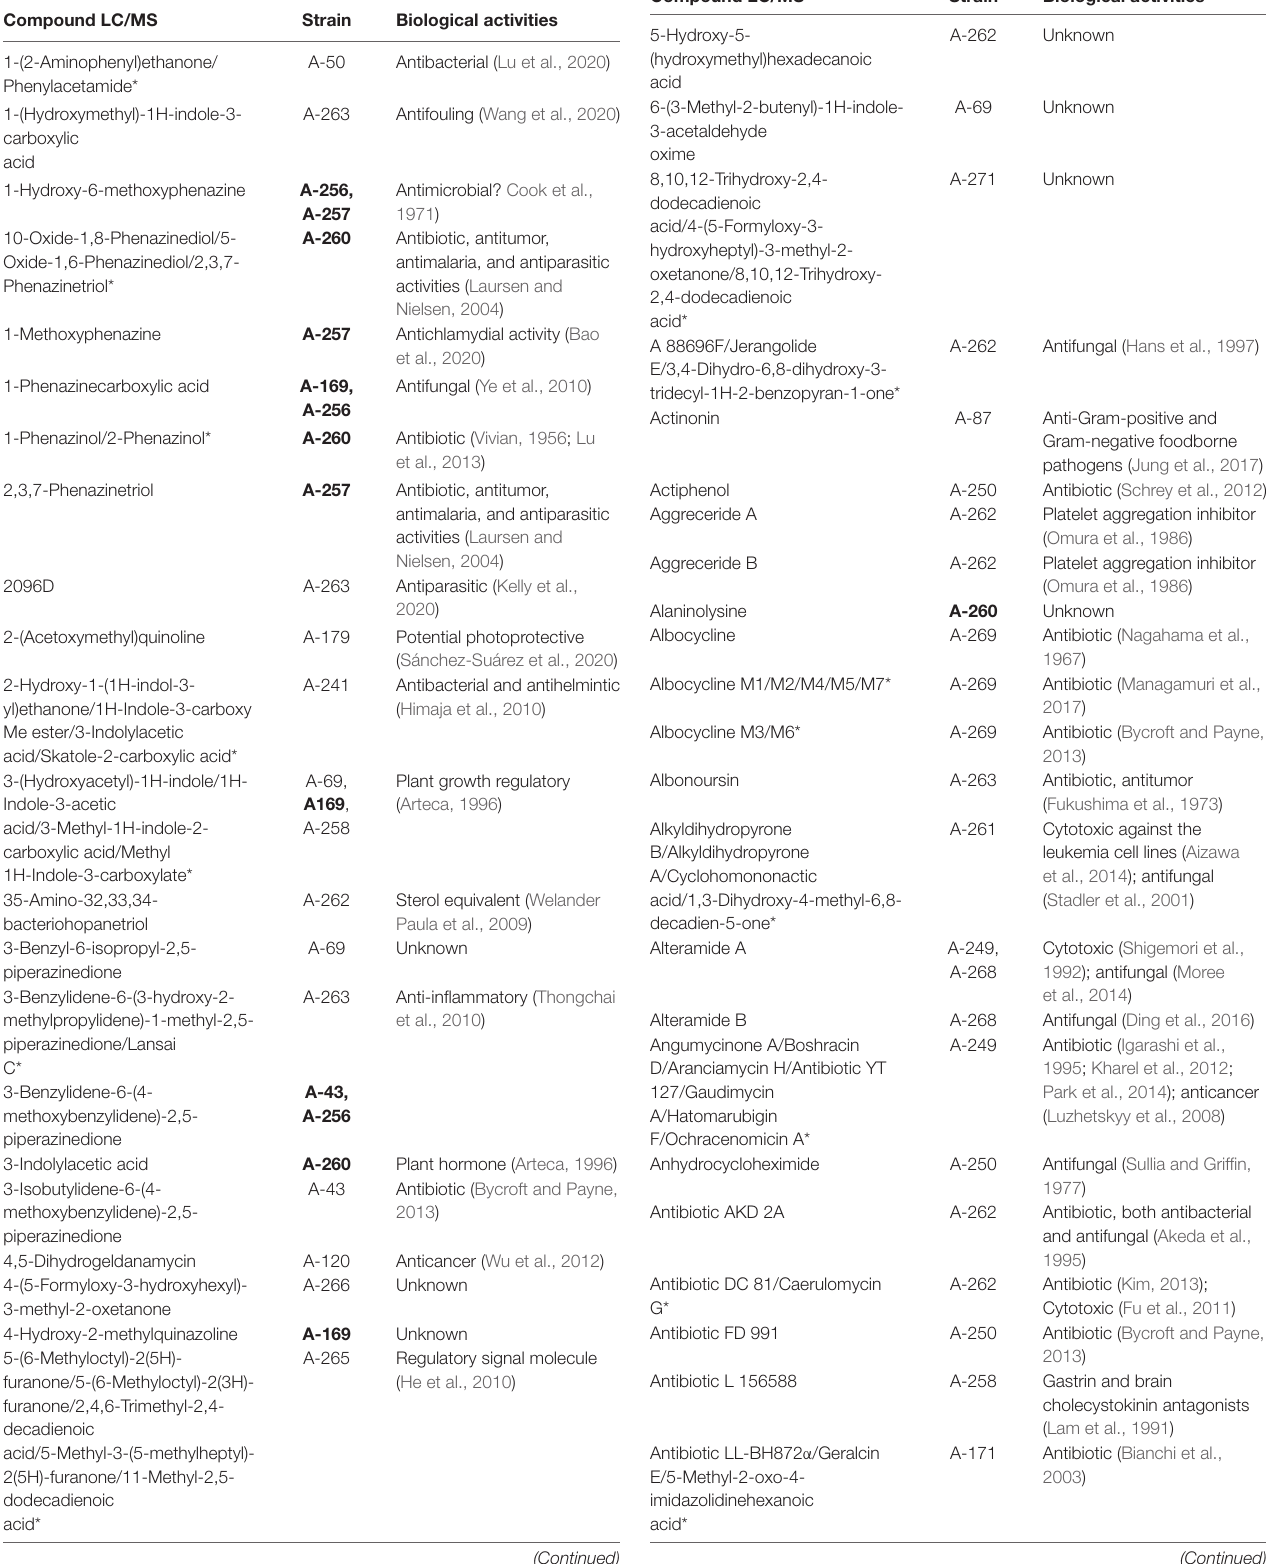
TABLE 4 | Identified compounds produced by atmospheric derived Actinobacteria strains and their biological activities. Compound